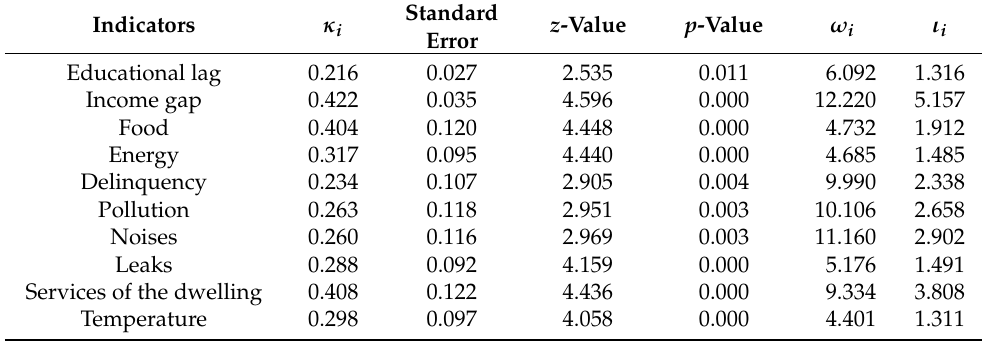
Table 8. Instrumental effects of social